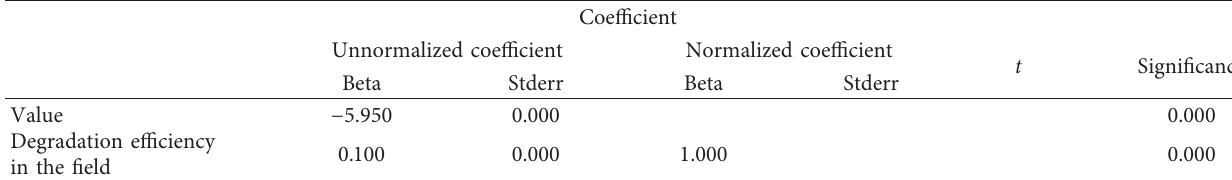
Table 6: Correlation coefficient of the linear regression